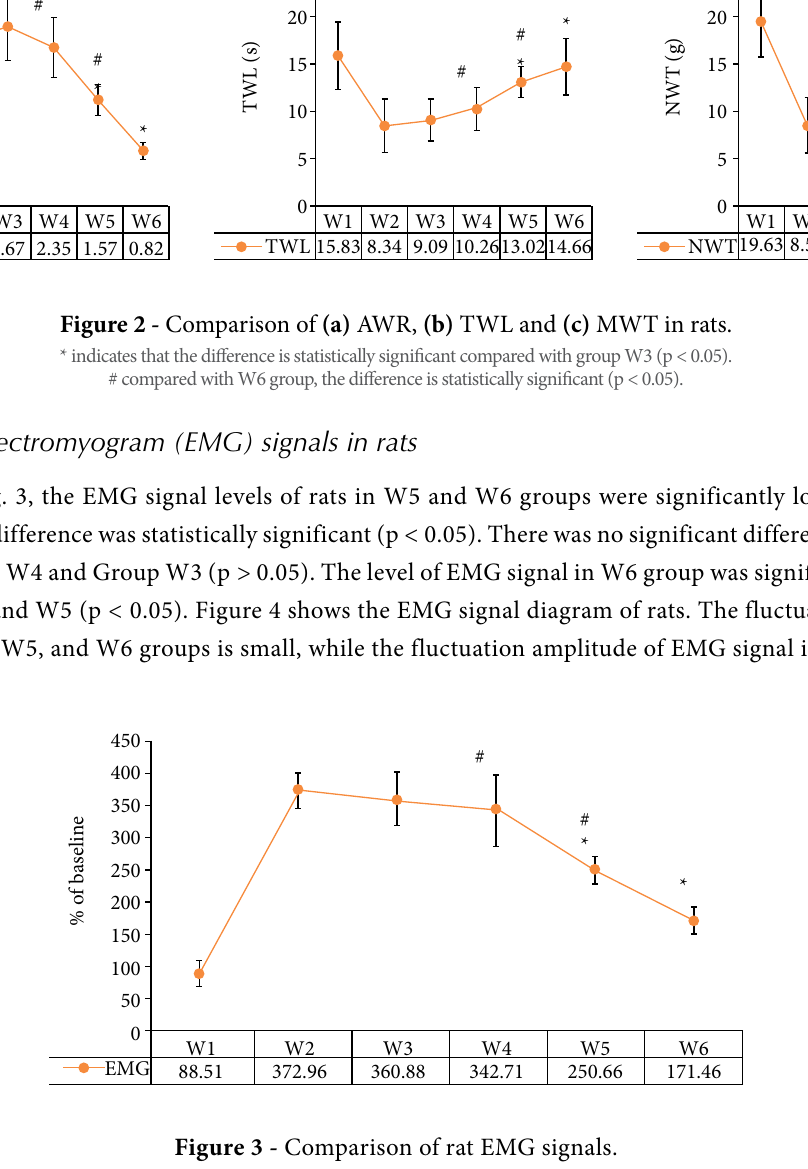
Figure 3 - Comparison of rat EMG